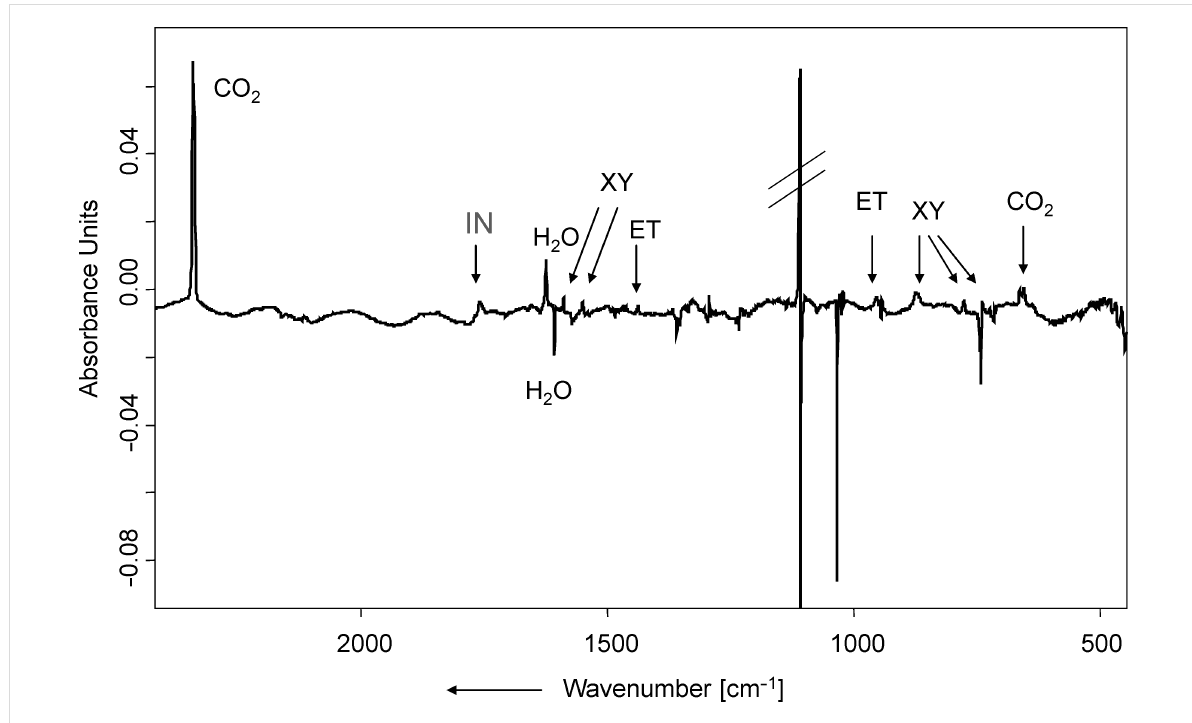
Figure 3: Difference infrared spectrum, showing the changes in the IR spectrum after photolysis ( λ exc = 254 nm, 20 min) of 1 in Ar matrix. Except for the water band, all IR bands pointing downwards belong to 1 . Product bands pointing upwards are labelled according to their assignment ( XY = o -xylylene, ET = ethylene, IN = indan-2-one). The intense band pointing upwards at 1109 cm − 1 is an artefact due to a subtraction error of a very intense precursor